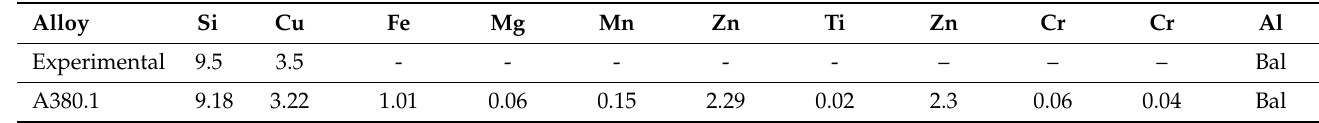
Table 2. Chemical composition of the as-used alloys (wt%).